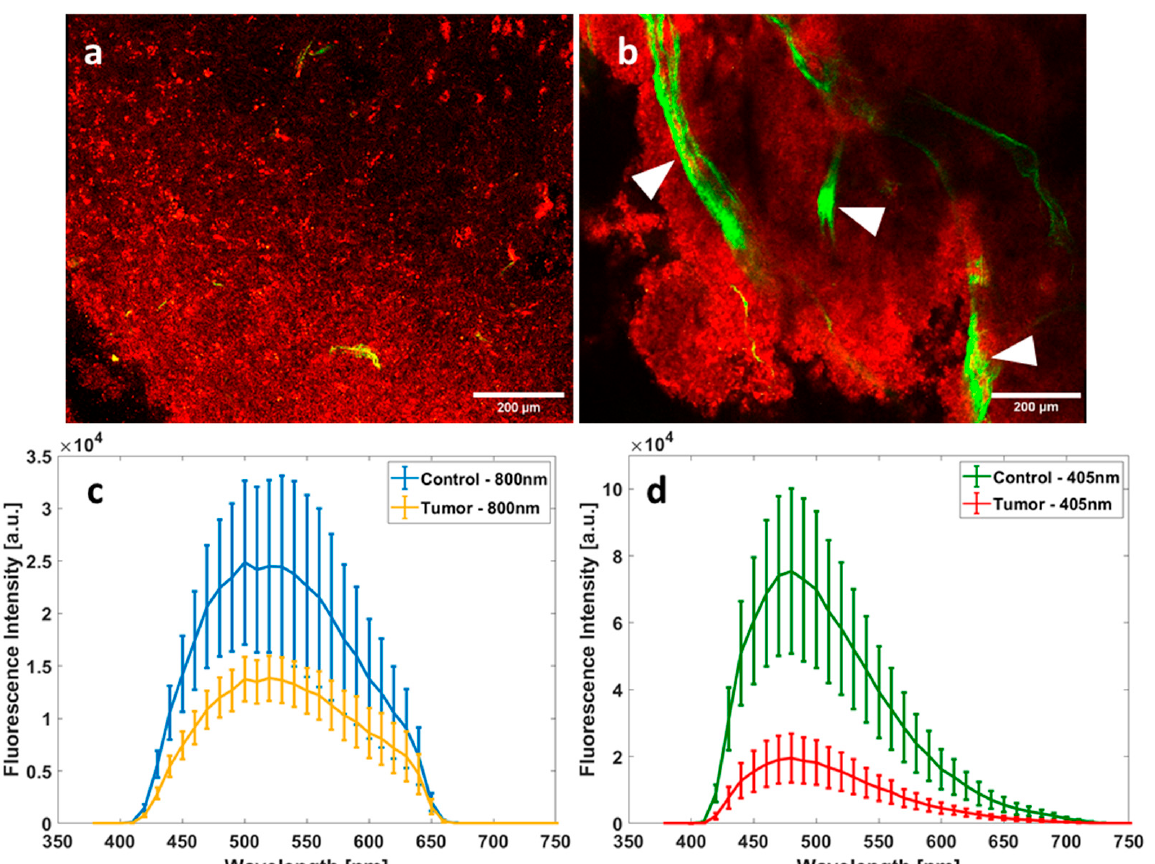
Figure 2. Spectral and imaging acquisitions of control and tumor samples under one- and two-photon excitation. Fluorescence and SHG microscopic images from the multimodal microscope set-up under 890 nm excitation for control ( a ) and for GBM ( b ); Scale bars: 200 µm; red pixels refers to fluorescence signal while green pixels refers to SHG signal; white arrows highlight blood vessels. Comparison between the mean fluorescence emission of control tissues and GBM tissues using 800 nm as excitation wavelength ( c ) and 405 nm as excitation wavelength ( d ); a.u: arbitrary unit.